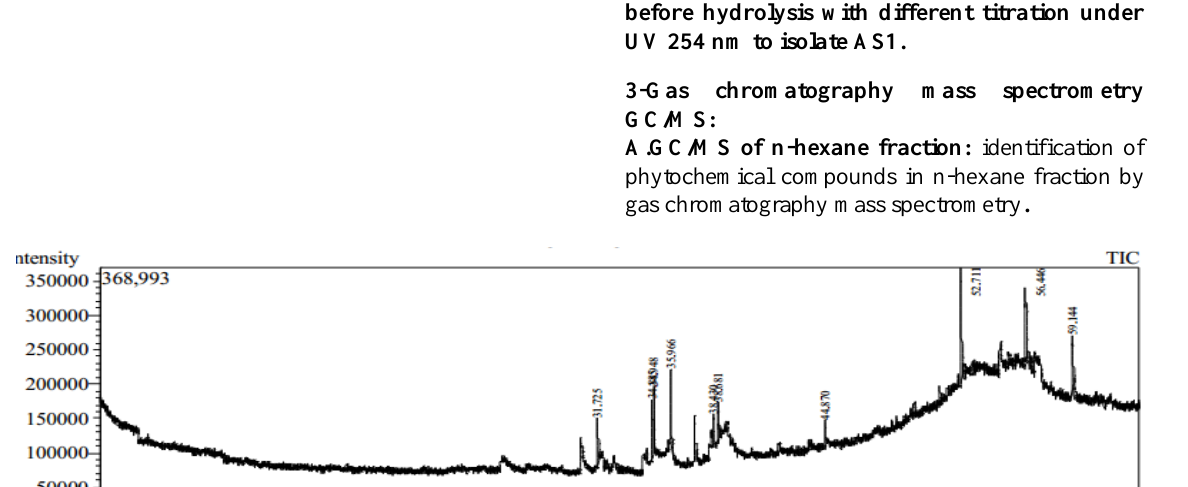
Figure 5. Preparative TLC of n-butanol fraction before hydrolysis with different titration under UV366 nm to isolate AS1. Figure 6. Preparative TLC of n-butanol fraction